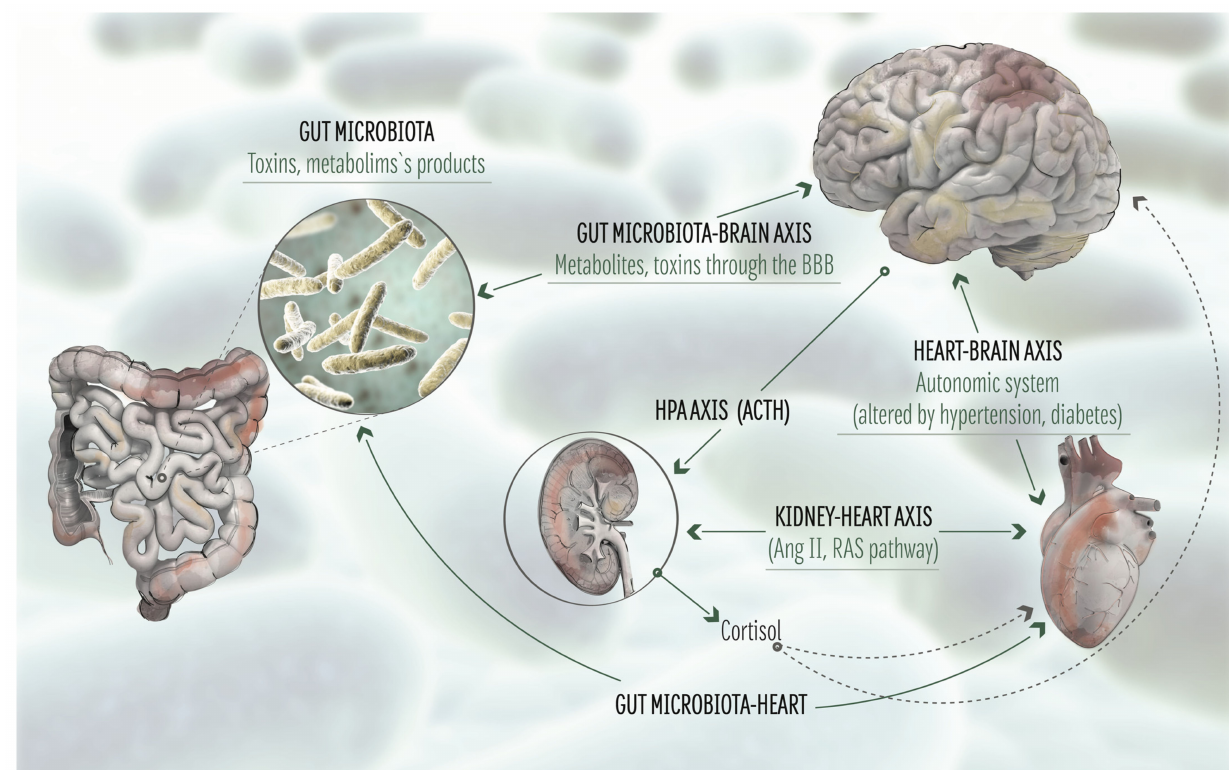
Figure 1. The microbiota-gut-brain-heart axis. Schematic representation of the major pathways implicated in the microbiota-gut-brain-heart axis. BBB: Blood Brain Barrier. HPA: Hypothalamic-pituitary-adrenal axis. ACTH: adrenocorti- cotrophic hormone. Ang II: angiotensin II. RAS: Renin-Angiotensin